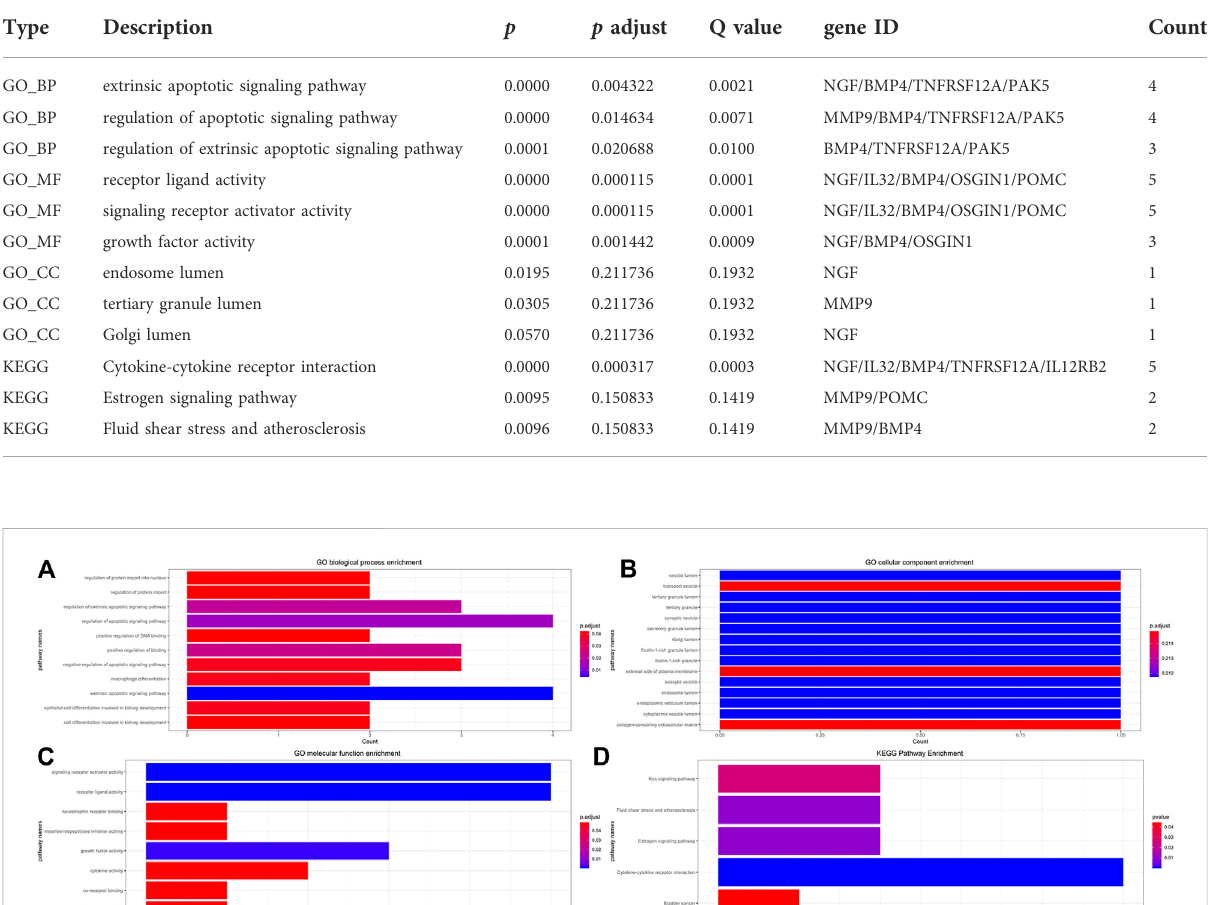
TABLE 4 Main results of GO and KEGG enrichment analysis for signi fi cantly expressed immune genes.